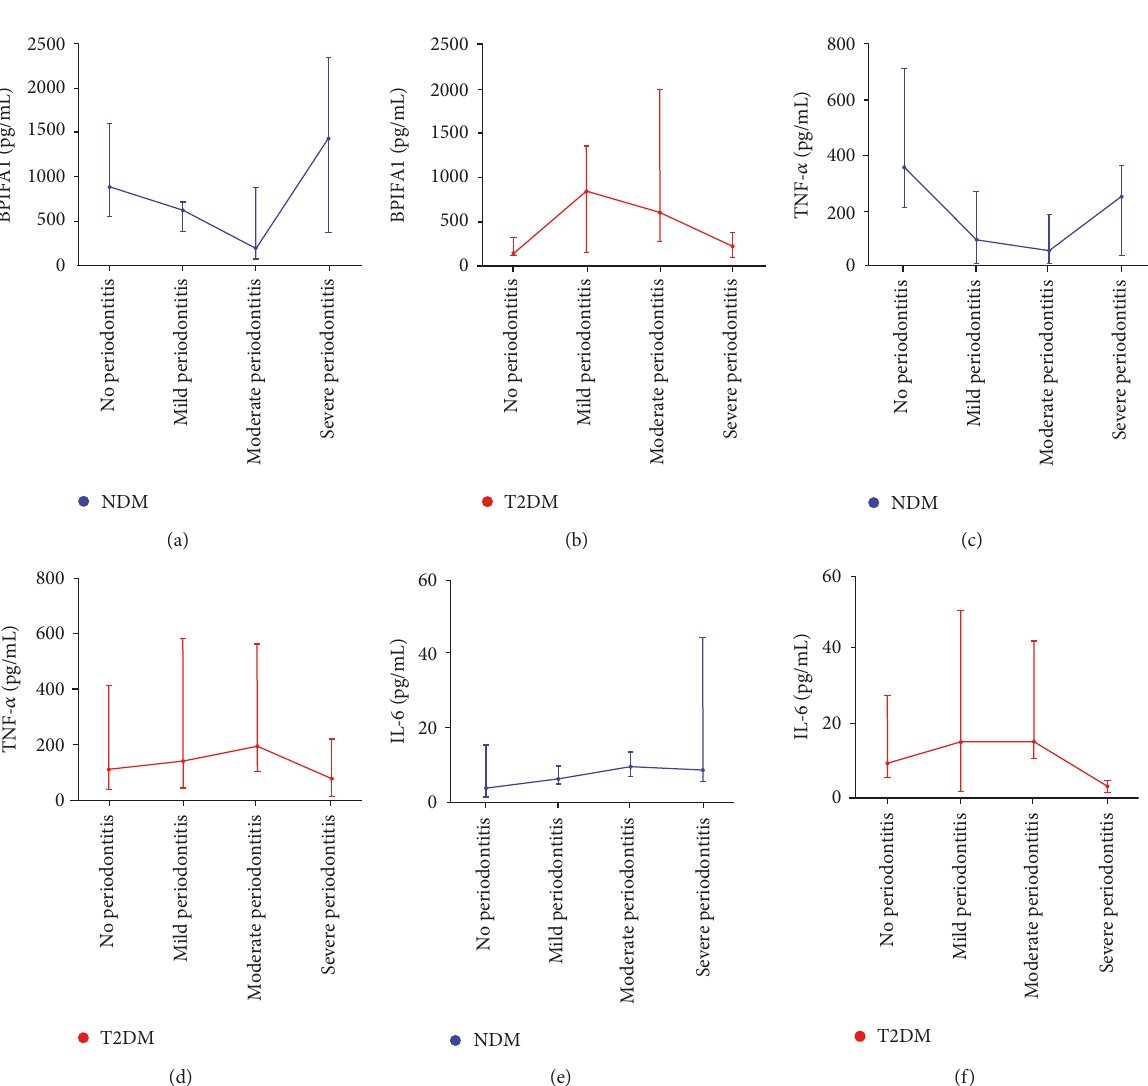
Figure 2: Line graph including salivary BPIFA1, TNF- α , and IL-6 (pg/mL, median (IQR)) concentrations in di ff erent severities of periodontitis strati fi ed by T2DM. Blue lines and dots represent NDM subjects, and the red lines and dots represent T2DM subjects. Each group included 4 grades of periodontitis by severity including none, mild, moderate, and severe, and the median values are displayed (dots). The concentration of BPIFA1 (a) in the nonperiodontitis group was signi fi cantly higher than in the moderate periodontitis group. The level of BPIFA1 in the moderate periodontitis group was signi fi cantly lower than in the severe periodontitis group. The concentration of BPIFA1 was at its lowest in the moderate periodontitis group. However, in those with T2DM, the concentration of BPIFA1 (b) was signi fi cantly lower in the nonperiodontitis group in comparison to both the mild periodontitis and moderate periodontitis groups. BPIFA1 in the severe periodontitis group was signi fi cantly lower than in the mild and moderate periodontitis groups. Comparisons between the T2DM and NDM groups revealed that in T2DM subjects without periodontitis, BPIFA1 levels were signi fi cantly lower in those NDM subjects without periodontitis and was signi fi cantly lower in T2DM subjects with severe periodontitis individuals compared with NDM subjects with severe periodontitis. The concentration of TNF- α is shown in (c) and (d). In NDM subjects, the concentration of TNF- α in the nonperiodontitis group was signi fi cantly higher than in the mild periodontitis group and moderate periodontitis groups. BPIFA1 was signi fi cantly lower in the moderate periodontitis group compared with the severe periodontitis group. However, in those subjects with T2DM, the concentration of TNF- α was signi fi cantly lower in the severe periodontitis group in comparison to the moderate periodontitis group. Comparisons between T2DM and NDM groups revealed that T2DM subjects with moderate periodontitis had signi fi cantly lower BPIFA1 than NDM subjects. The concentration of IL-6 among the NDM and T2DM groups is presented in (e) and (f), which showed that the concentration of IL-6 in the moderate periodontitis group was signi fi cantly higher than in the severe periodontitis group, among T2DM